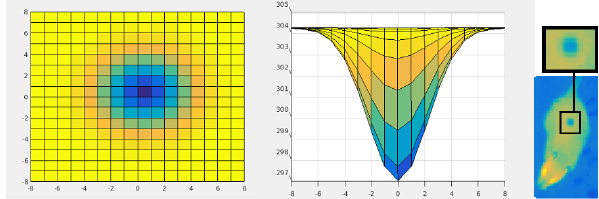
Figure 7. Circular trace with temperature 297 K and size 4 px. The trace in matrix ( left ), trace cross section ( center ), and the imposition of a trace on the image ( right